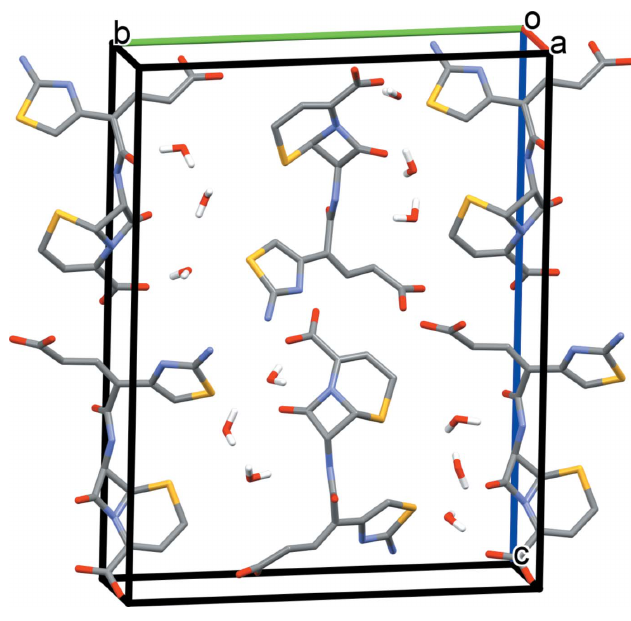
Figure 4 Packing diagram of (II). Non-water H atoms are omitted for clarity.